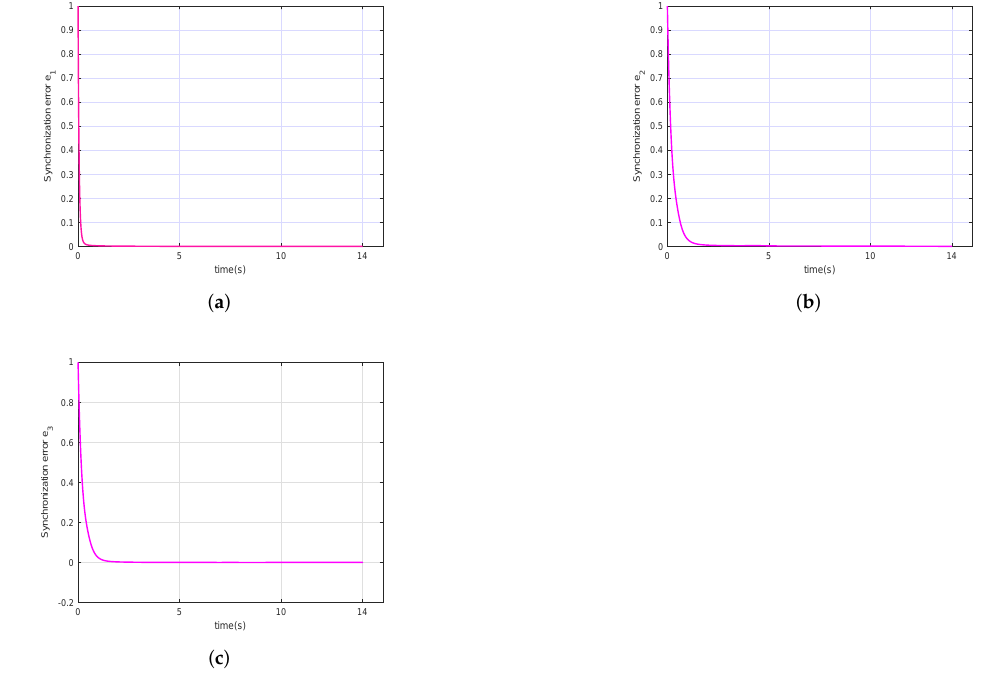
Figure 3. Synchronization error of drive and slave systems in Example 1: ( a ) x 1 − y 1 , ( b ) x 2 − y 2 , ( c ) x 3 − y 3